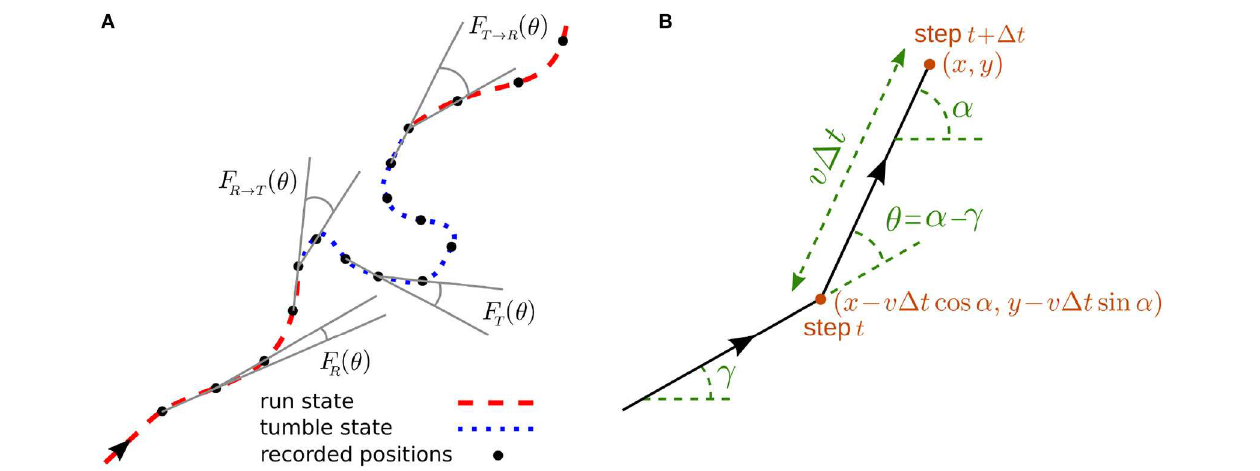
FIGURE 1 | (A) A sample trajectory with run-and-tumble dynamics. Typical turning angles for different types of turning-angle distributions introduced in the model are shown. (B) Trajectory of the walker during two successive